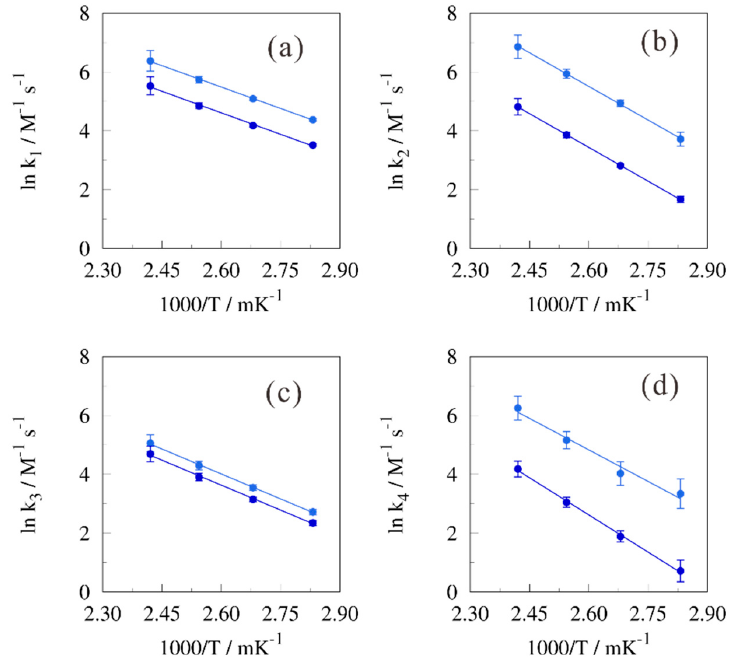
Figure 7. Arrhenius diagram for kinetic coe ffi cients ( a ) k1 ; ( b ) k2 ; ( c ) k3 ; and ( d ) k4 when n-butanol is used as solvent. Points and linear regression lines are for the ( ─ , ● ) uncorrected data and ( ─ , ● ) the corrected data using the average activity coefficients as reported in Table 5.